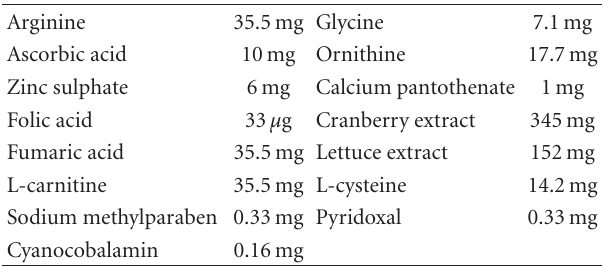
Table 1: Composition of Diamel